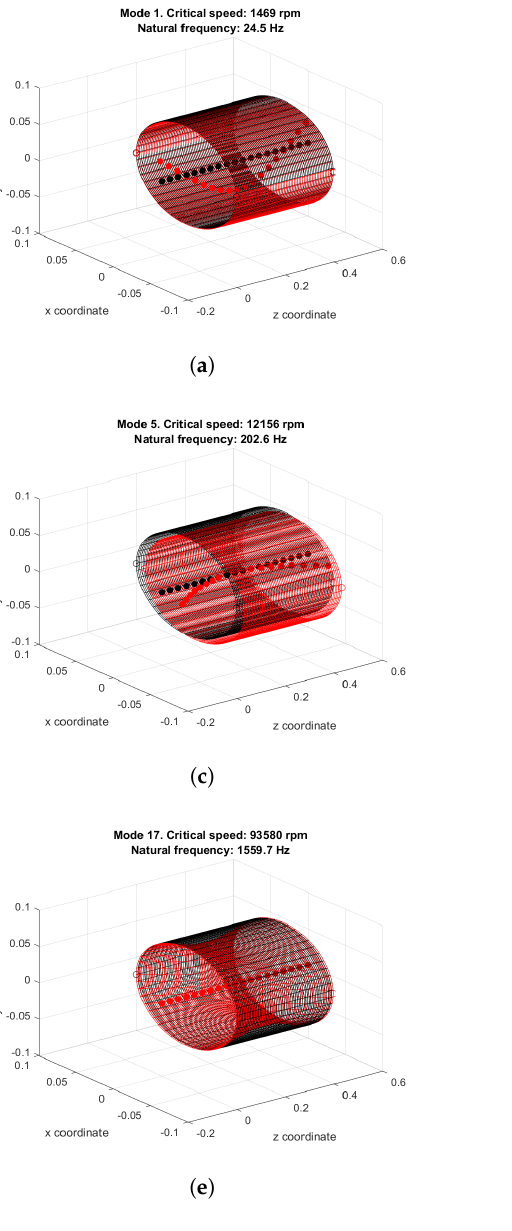
Figure 5. Lowest shaft and casing natural modes: ( a ) rotor bending mode with one antinode; ( b ) rotor bending mode with two antinodes; ( c ) casing rigid solid mode with shaft deflection; ( d ) lowest casing longitudinal mode; and ( e , f ) lowest casing flexural